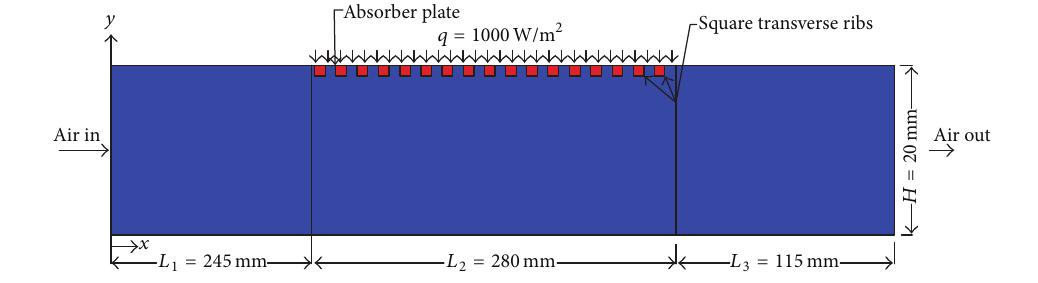
Figure 1: Geometry of two-dimensional computational domain.